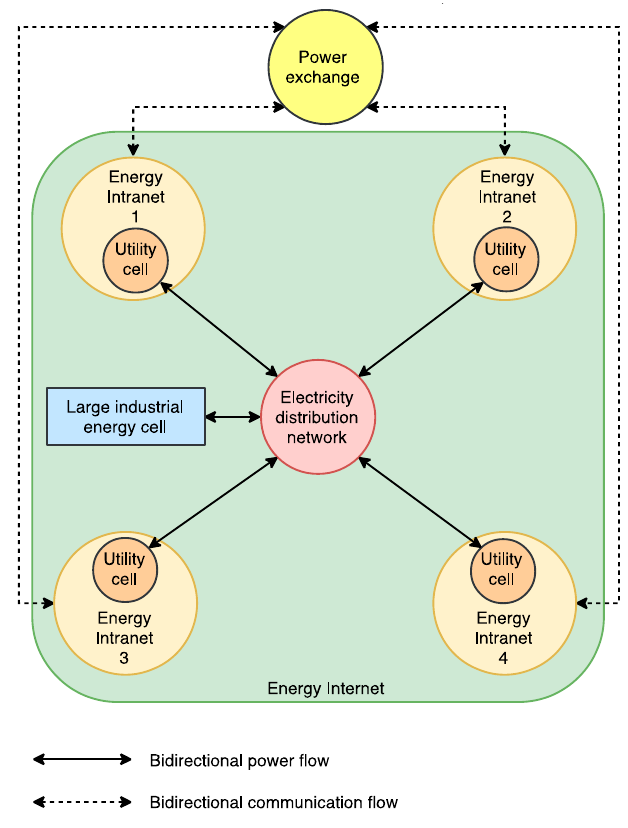
Figure 3. Energy Internet as the network of Energy Intranets.